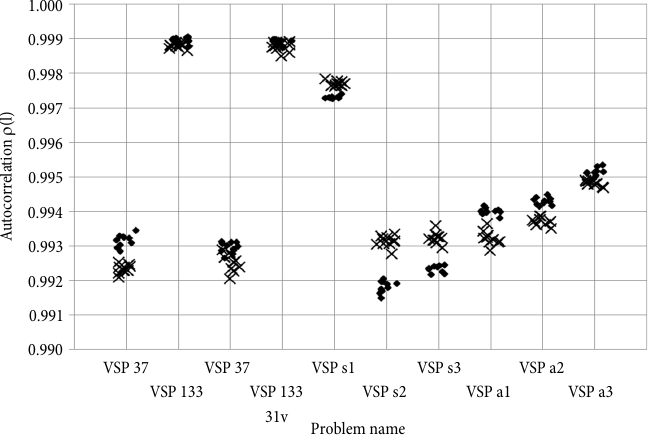
Fig. 4. Autocorrelation in up-down walks